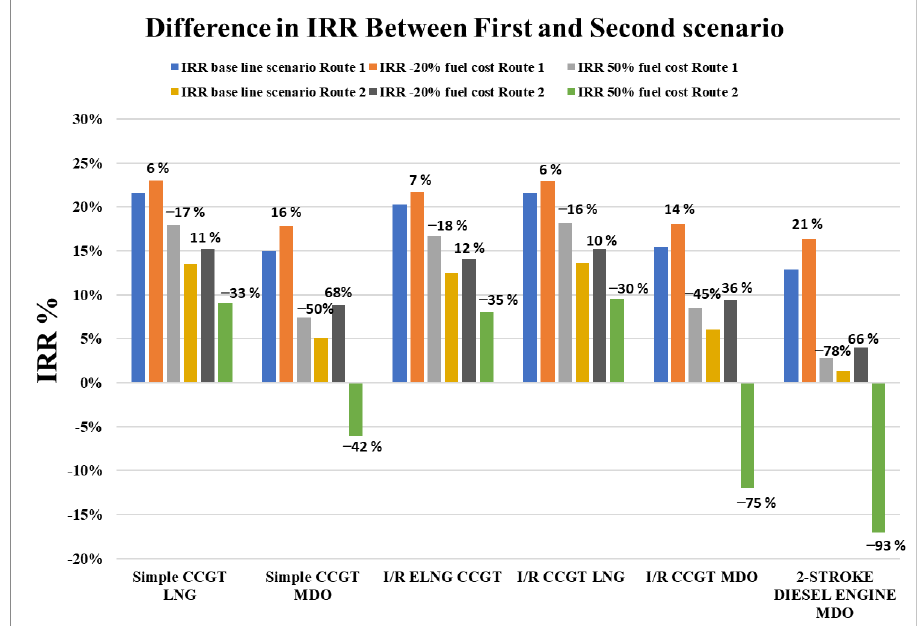
Figure 6. Difference in IRR between the first and second scenarios for Routes 1 and 2.